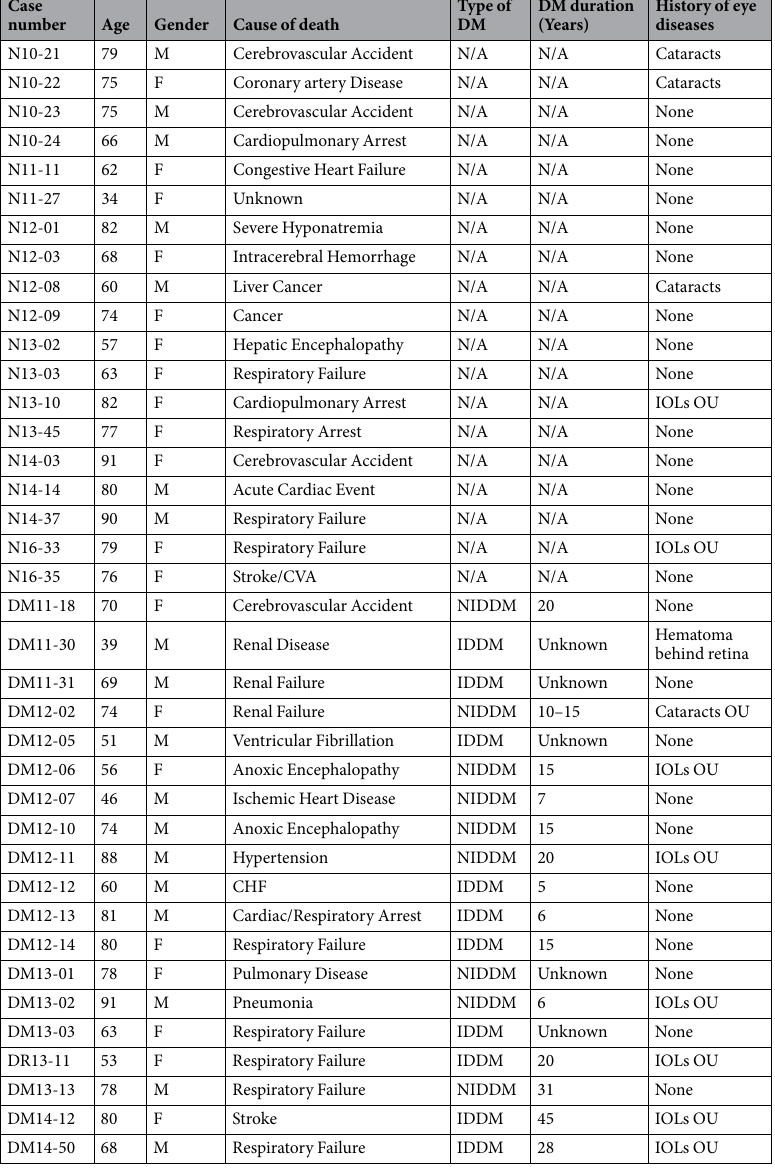
Table 1. List of corneas used in this study. N, normal; DM, diabetic mellitus; IDDM, T1DM; NIDDM, T2DM; M, male; F, female; IOL, intraocular lens; OU, both